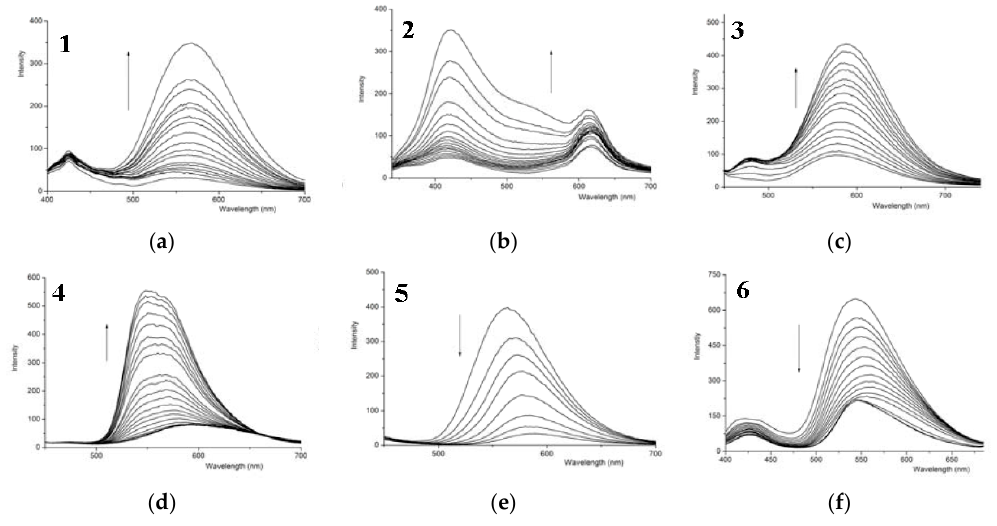
Figure 4. Fluorescence response of six compounds (4.0 × 10 − 5 mol·L − 1 ) with acetate anion addition (0–2.0 × 10 − 3 mol·L − 1 ). Arrows indicate the increase in direction of acetate concentration. ( a ) Compound 1 ; ( b ) Compound 2 ; ( c ) Compound 3 ; ( d ) Compound 4 ; ( e ) Compound 5